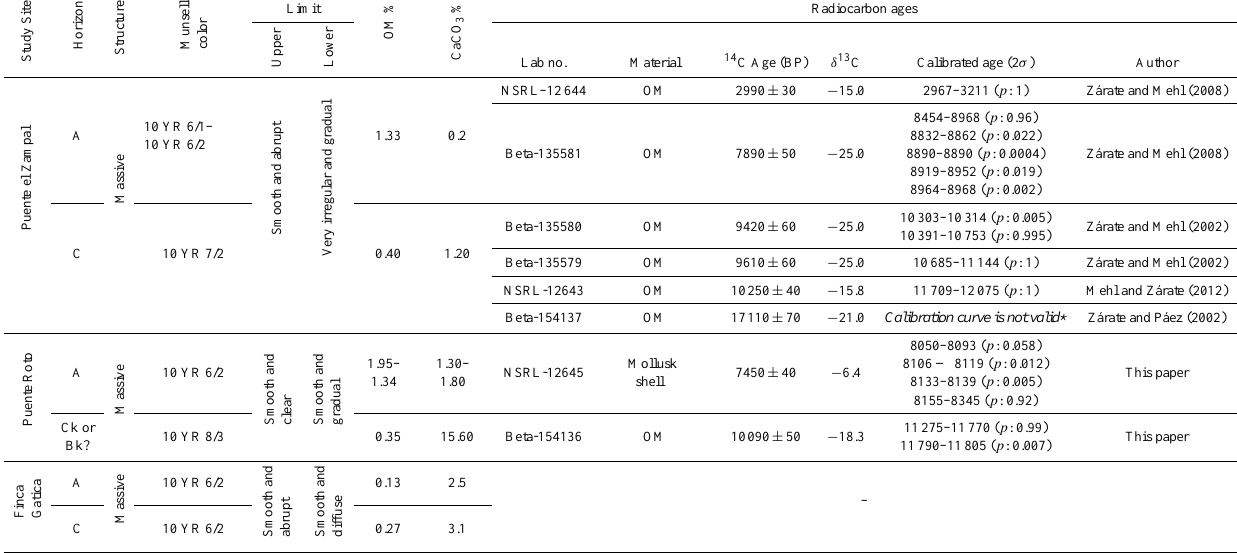
Table 1. Late Pleistocene–Holocene transition paleosol: horizonation, structure, air-dried color sample (Munsell Soil Color Chart, 2000), limits, organic matter (OM)–calcium carbonate (CaCO 3 ) contents, and radiocarbon ages at the three involved study sites. Calibrated radio- carbon ages: Calib 6.1.0 Program (Stuiver, Reimer & Reimer Copyright 1986–2011, http://calib.qub.ac.uk/calib/) and McCormac et al. (2004) calibration data sets were